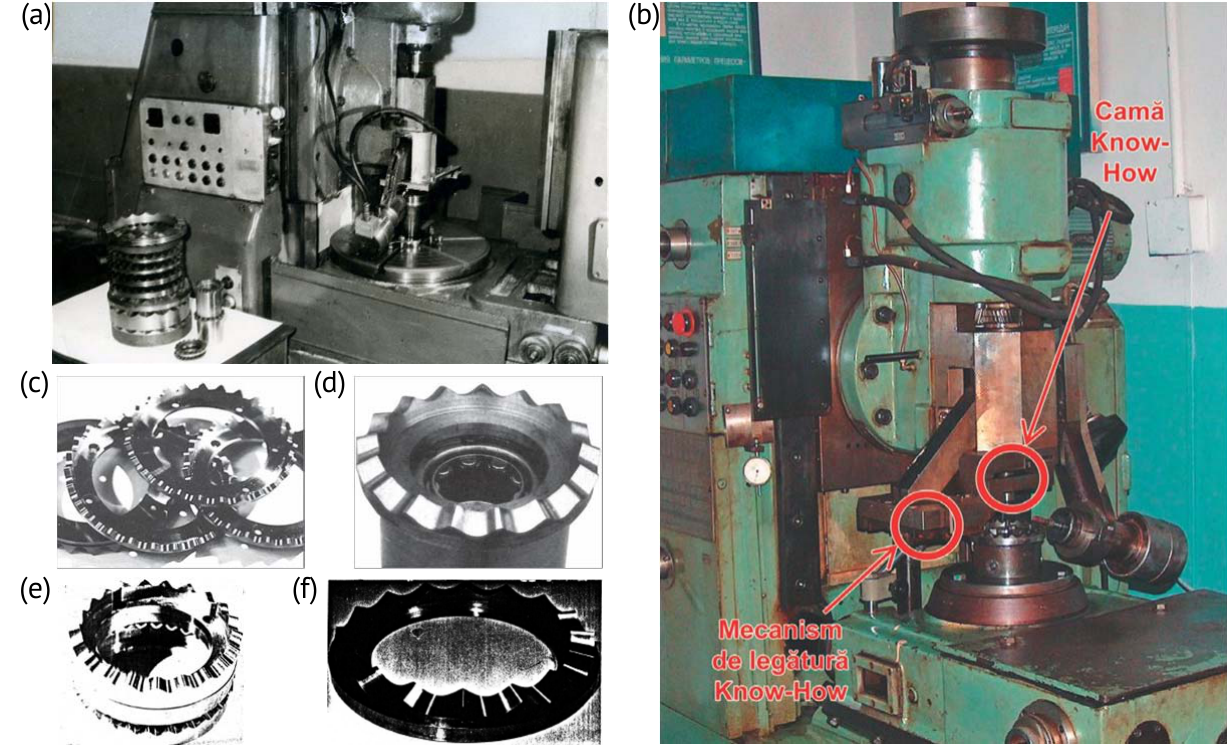
Figure 11. Machine-tool with teeth generation device with the tool in the shape of a truncated cone for generating the gear teeth by milling (a), rectification (b) and samples of manufactured toothed wheels by rectification for transmissions with reducer (c), (d), (e) and multiplier (f)